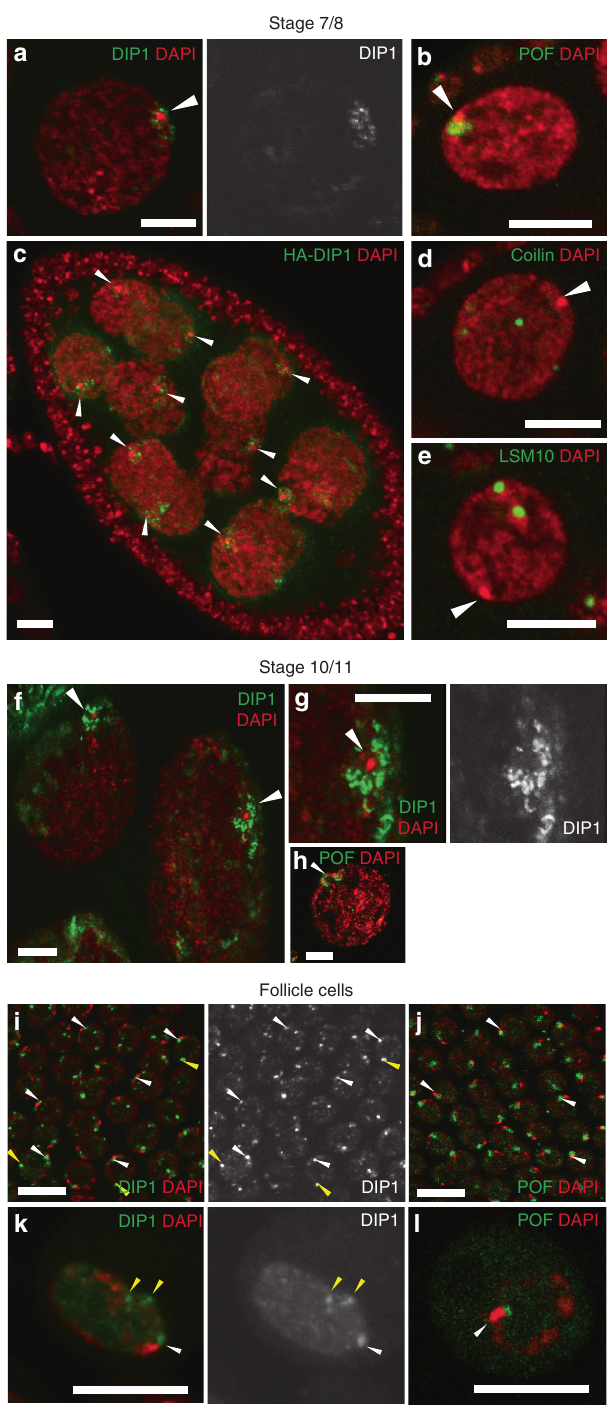
Fig. 5 Satellite bodies are DIP1-positive nuclear bodies that decorate the fourth chromosomes. a A stage 7/8 nurse cell stained for DIP1 and DAPI. b , d , e A stage 7/8 nurse cell stained for b POF, d Coilin, and e LSM10. c A stage 7/8 egg chamber expressing HA-DIP1 protein under MTD-Gal4 , stained with anti-HA. f Two stage 10/11 nurse cells stained for DIP1 and DAPI. g A magni fi ed view of satellite bodies in f . h A stage 10/11 nurse cell stained for POF and DAPI. Arrowheads point to DAPI-dense regions of fourth chromosomes. i , j Follicle cells stained for i DIP1 and j POF. k , l S2 cells stained for k DIP1 and l POF. White arrowheads point to chromosome four associated bodies, while yellow arrowheads point to bodies that do not associate with chromosome four. Scale bar : 10 µ